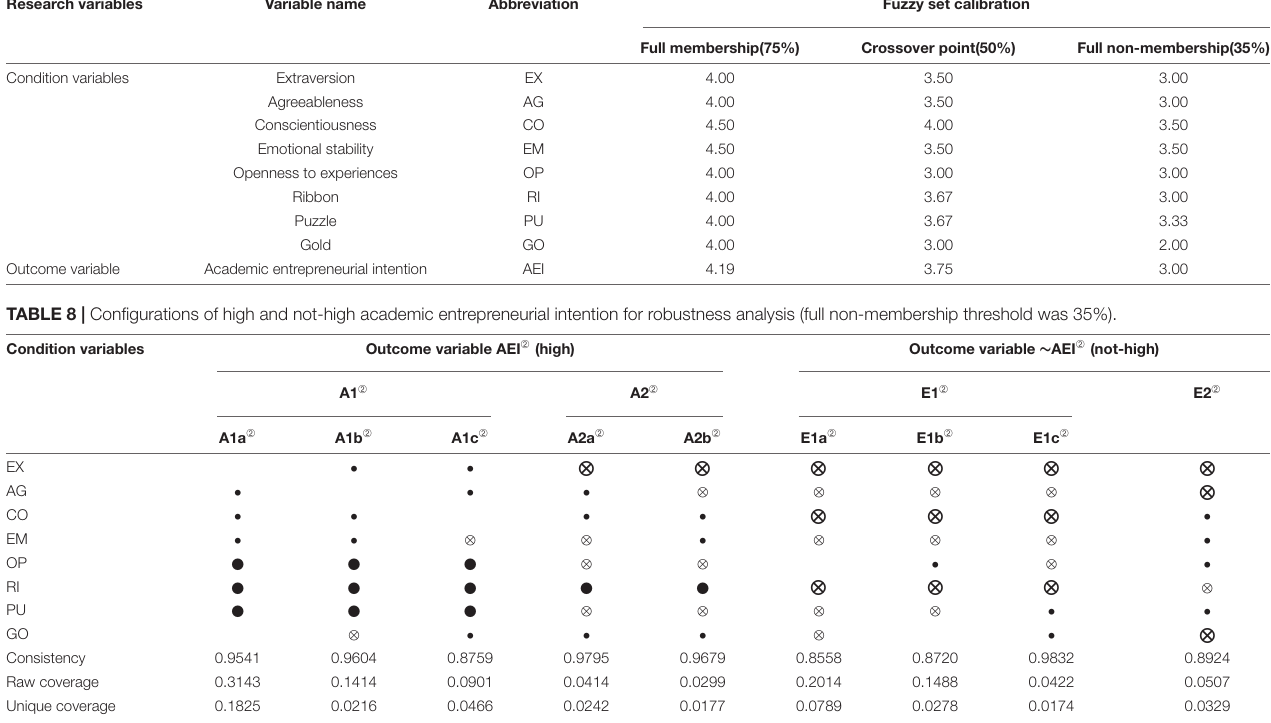
TABLE 7 | Robustness analysis (other conditions remain unchanged, full non-membership threshold was 35%). Research variables